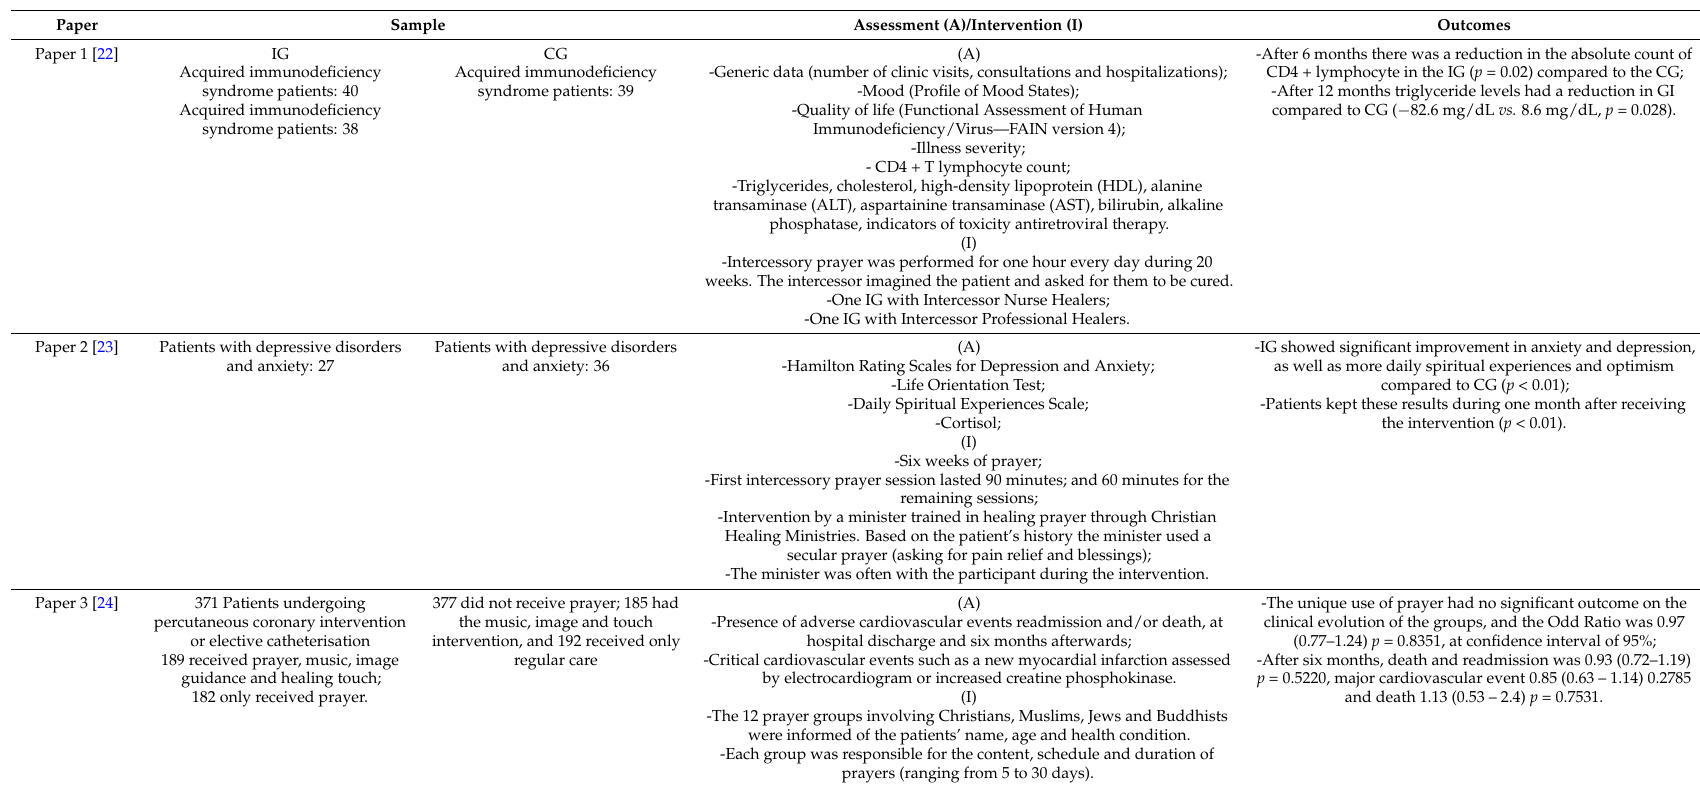
Table 1. Synthesis of the research papers included in the